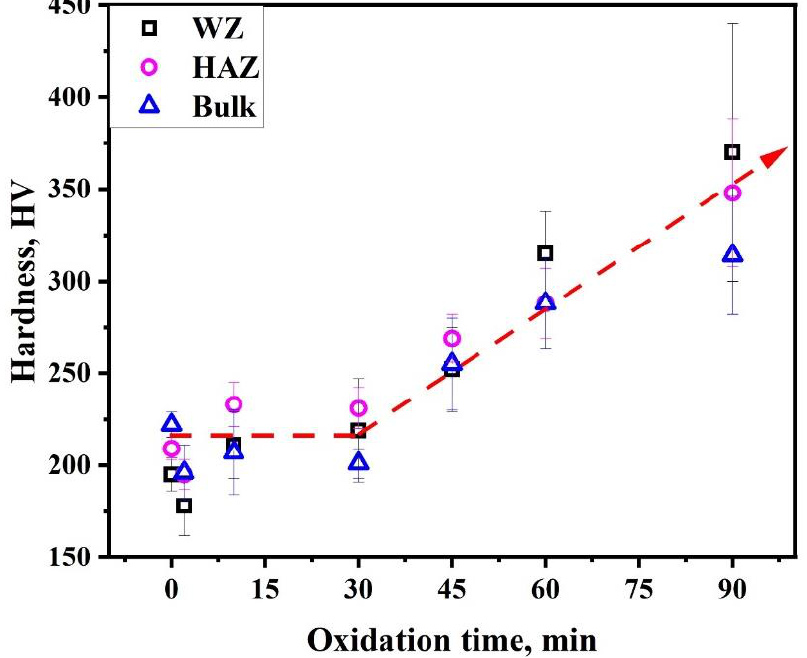
Figure 4. Hardness in different zones of Cr-coated LBW E110 alloy samples as a function of oxidation time.